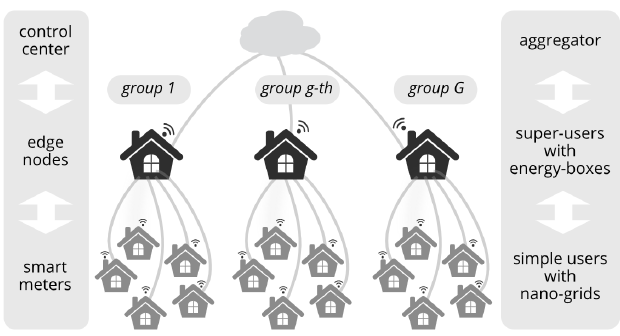
Figure 2. Edge computing architecture of the energy